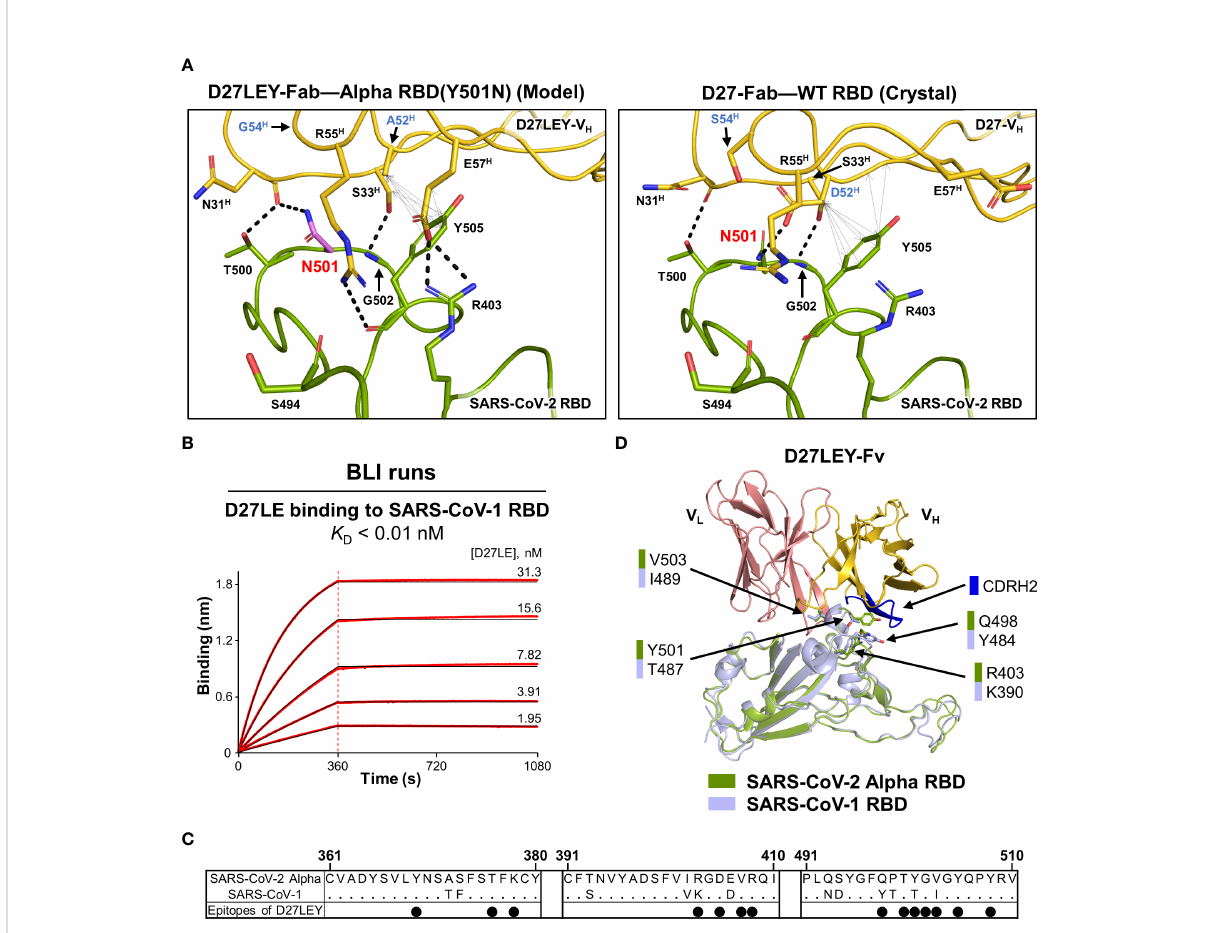
FIGURE 4 Interaction of D27LEY with RBDs having a smaller amino acid at residue 501. (A) N501 (in purple) was modeled on the structure of D27LEY-Fab – Alpha RBD using the Pymol software (Left) and shown together with the structure of D27-Fab – WT RBD (Right), which represents the interaction of D27LE with the WT RBD in this region. The D52 H A and S54 H G substitutions in comparison with D27LE are labeled in blue letters. Intermolecular polar and hydrophobic interactions (interatomic distances < 4.3 Å) are indicated by dashed lines and double-headed arrows, respectively, showing more extensive intermolecular interactions engaged by D27LEY than those by D27LE in this region. (B) BLI runs for measuring the binding af fi nity between D27LE and the SARS-CoV-1 RBD. The af fi nity exceeds the instrumental sensitivity ( K D < 0.01 nM). (C) Sequence alignment of the SARS-CoV-1 and Alpha RBDs. Residue numbering for the SARS-CoV-2 Alpha RBD is shown at the top. The black dots indicate the Alpha RBD epitope residues binding to D27LEY. (D) The structures of the SARS-CoV-1 RBD (PDB entry: 2DD8) and D27LEY- Fab – Alpha RBD are aligned. The four epitope residues different in the two RBDs are shown in sticks and labeled. Except T487/Y501, the other three residue pairs are not close to the CDRH2 loop (in